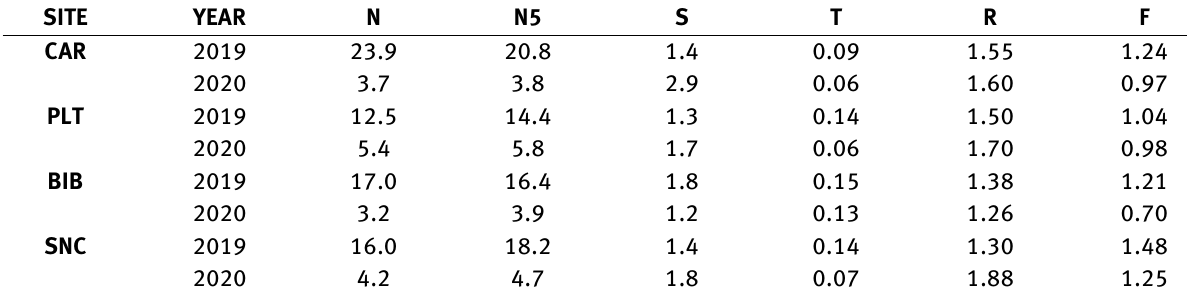
Table 4: Summary psychoacoustic metric data in Granada, before (2019) and during lockdown (2020) at four selected sites SITE